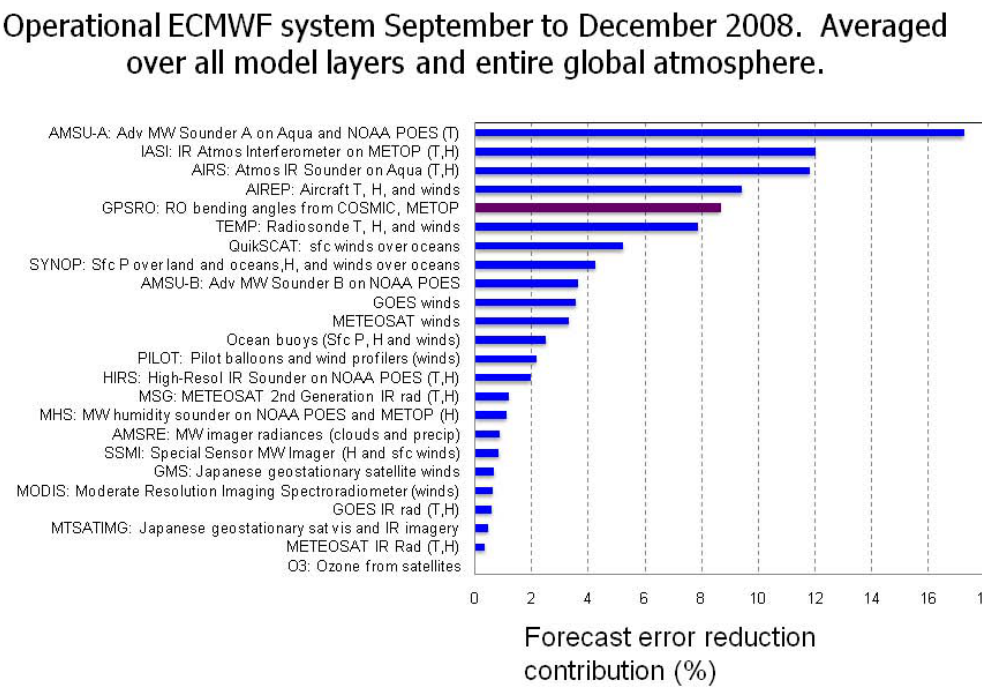
Fig. 30. Contribution to the reduction in forecast error (in percent) by all the observing systems used by the ECMWF. RO is the fifth most important observing system in reducing forecast error (Cardinali, 2009a, b).